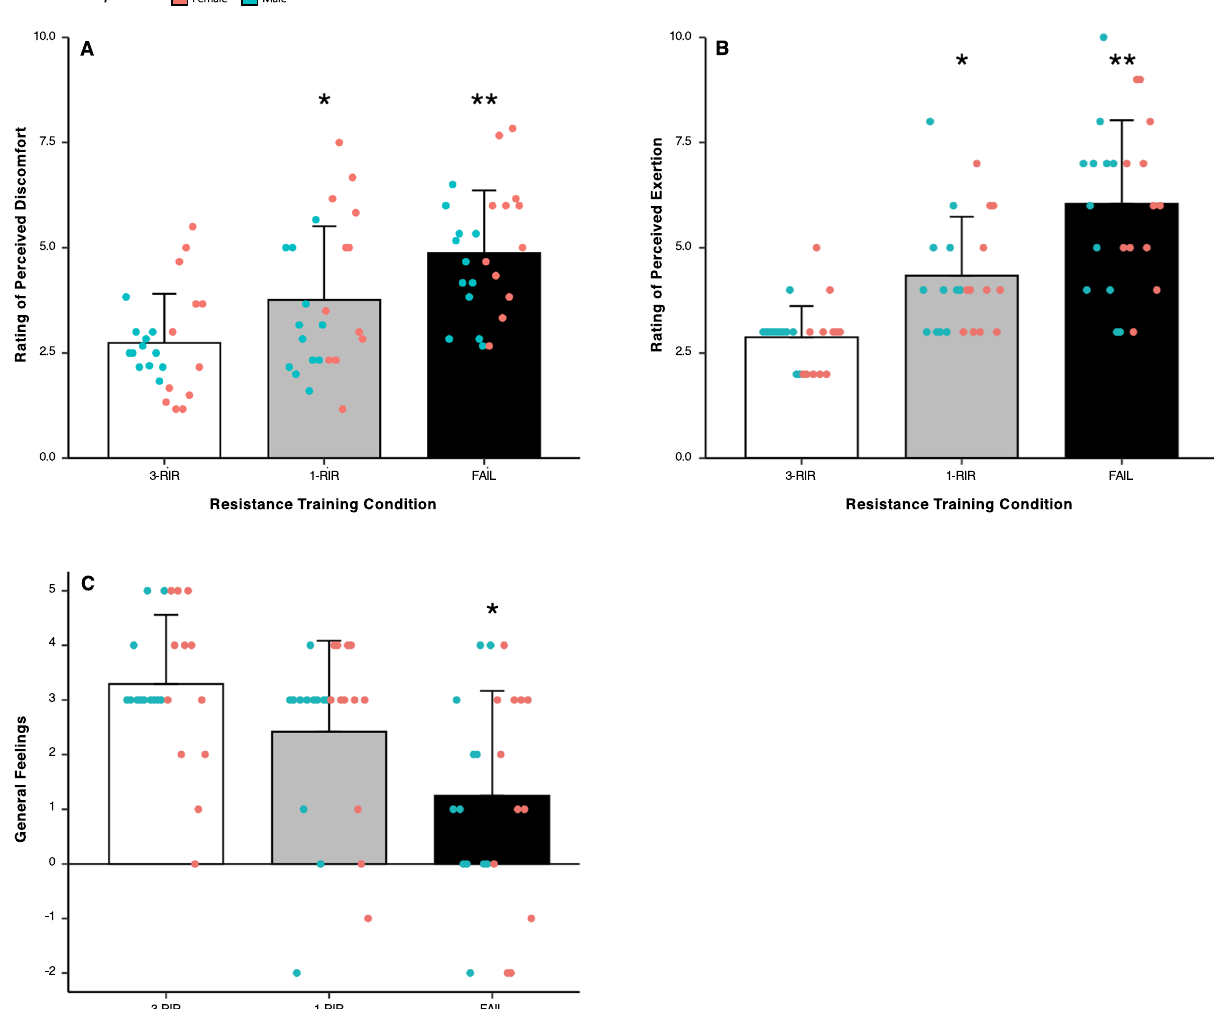
Fig. 7 Ratings of post-set perceived discomfort ( A ), post-exercise perceived exertion ( B ), and post-exercise general feelings ( C ). Data shown are presented as mean SD. *Denotes a statistically significant difference from 3-RIR condition. **Denotes a statistically significant difference from 1-RIR ± and 3-RIR